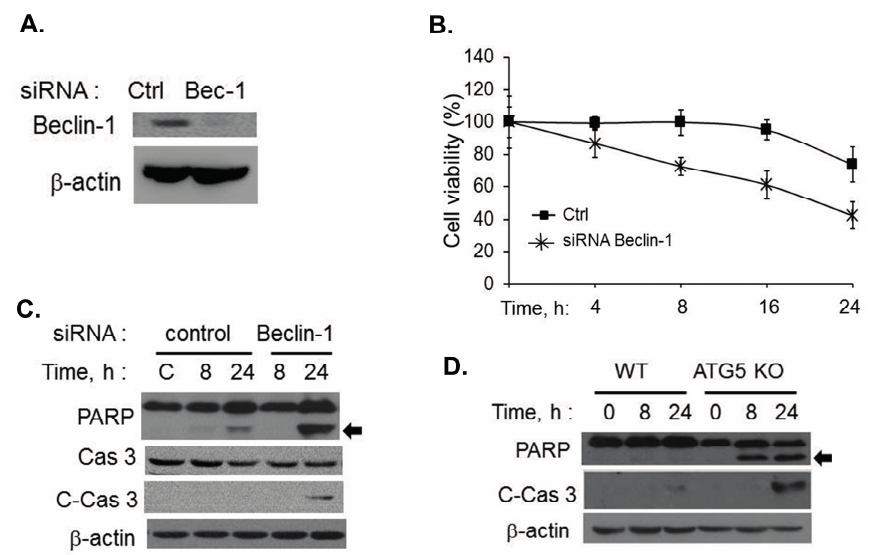
Figure 4. Cells lacking autophagy proteins undergo apoptosis in response to RNase L activation. ( A ) HT1080 cells were transfected with Beclin siRNAs (20 nM) or control siRNAs (20 nM) and knock down of Beclin-1 protein levels were determined on immunoblots; ( B ) Control or Beclin-1 siRNA expressing cells were transfected with 2–5A (10 µM) and cell viability was determined using MTT assay at indicated times. Results are representative of three independent experiments performed in triplicate ± SD; ( C ) Cleavage of PARP (indicated by arrow) and caspase 3 was monitored in cell lysates of 2–5A treated knock-down cells and compared to control cells. Protein levels were and normalized to β -actin; ( D ) WT or Atg5 KO MEFs were transfected with 10 µM of 2–5A for indicated times and induction of apoptosis was monitored by cleavage of PARP (indicated by arrow) and cleaved caspase 3 on immunoblots normalized to β -actin levels. Results are representative of three independent